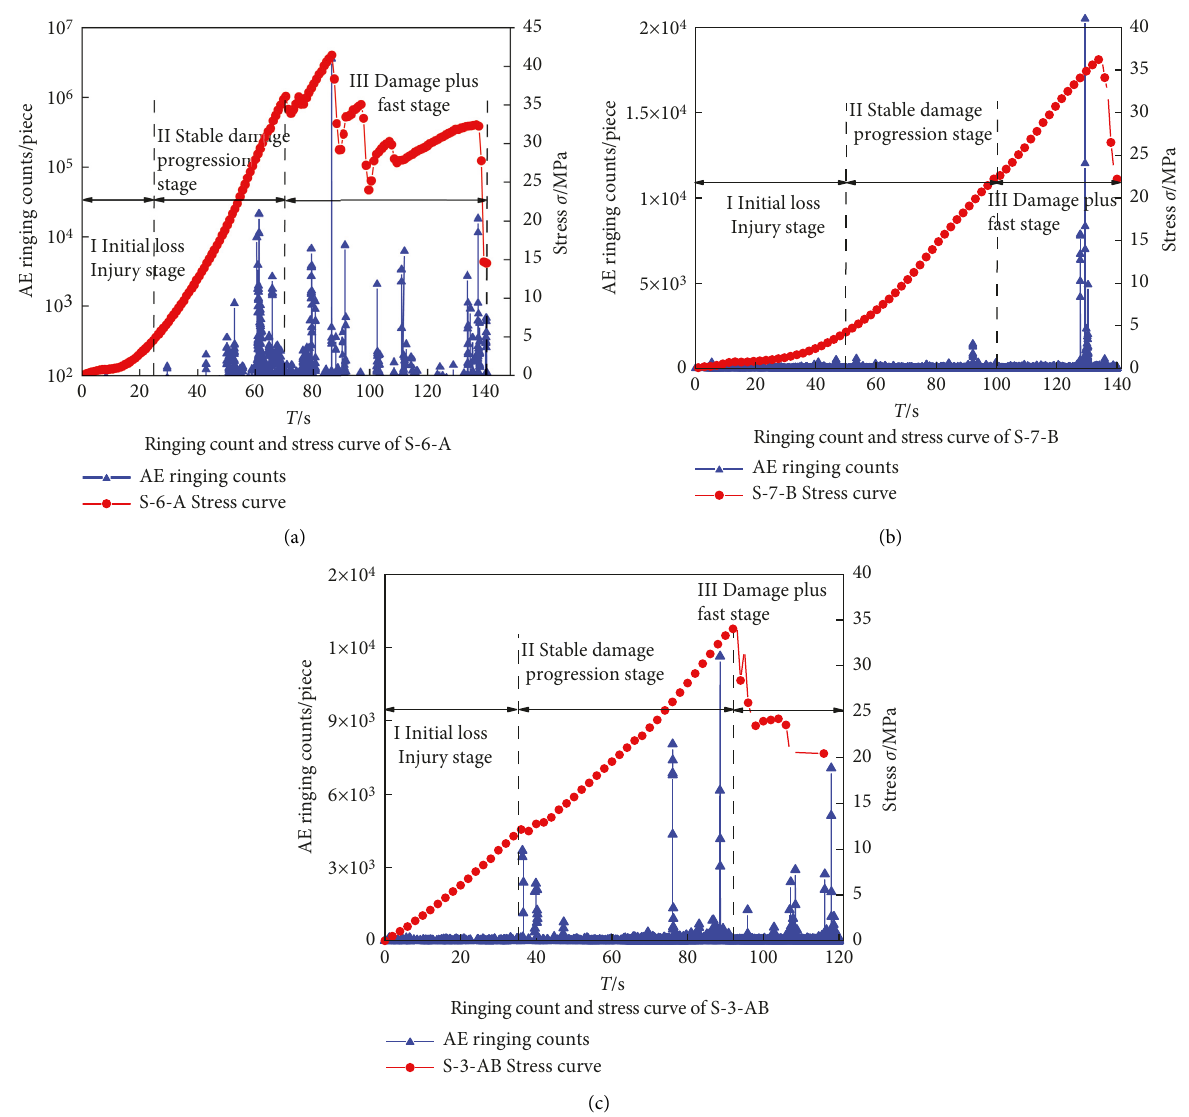
Figure 9: Curve of AE ringing count and stress-time. (a) Ringing count and stress curve of S-6-A. (b) Ringing count and stress curve of S-7-B. (c) Ringing count and stress curve of